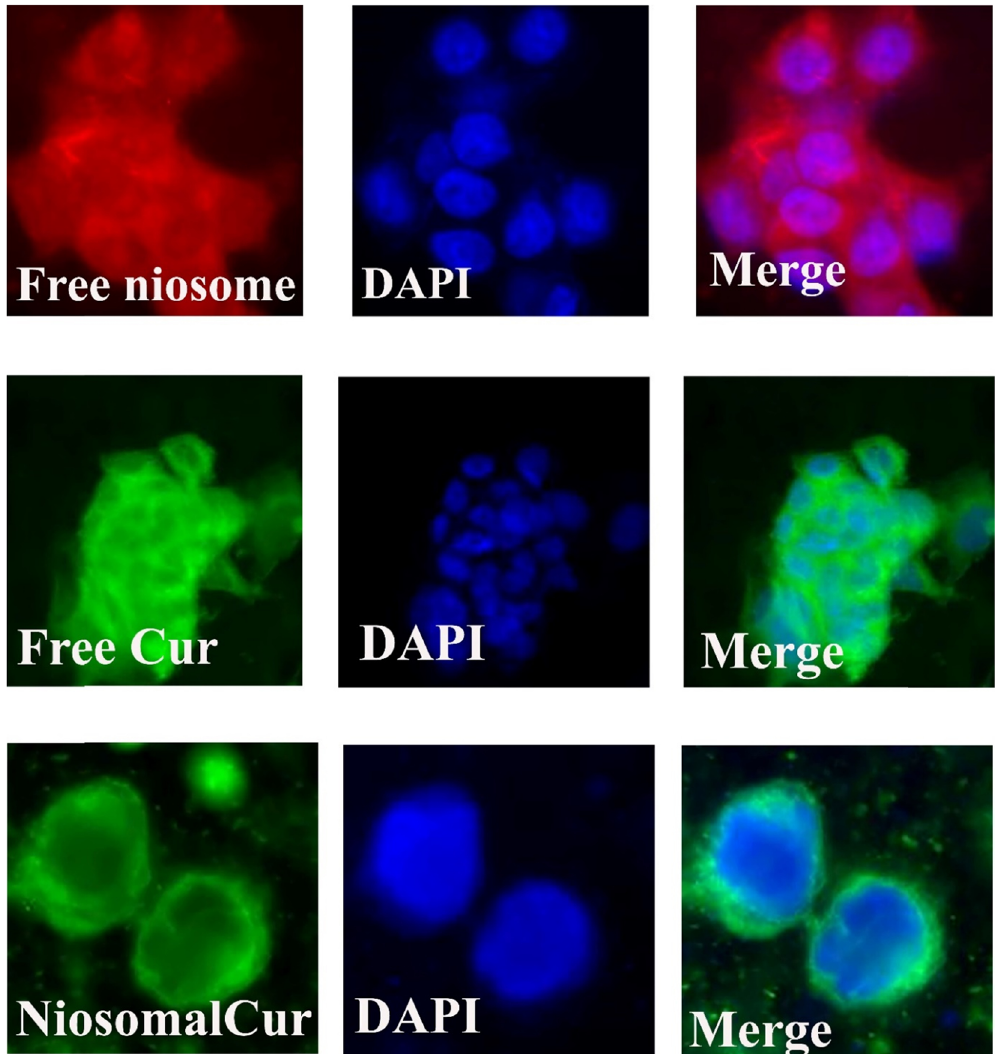
Figure 8: Cellular uptake images of A270cp - 1 incubated with the modi fi ed niosomal NPs for 4